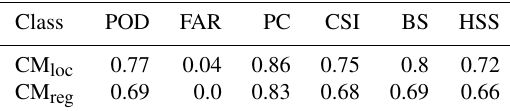
Table 1. CloudNet validation results for the cloud masks using the local (CM loc ) and the regional (CM reg ) threshold. Validation mea- surements used are as follows: probability of detection (POD), false alarm ratio (FAR), percentage correct (PC), critical success index (CSI), bias score (BS) and Heidke skill score